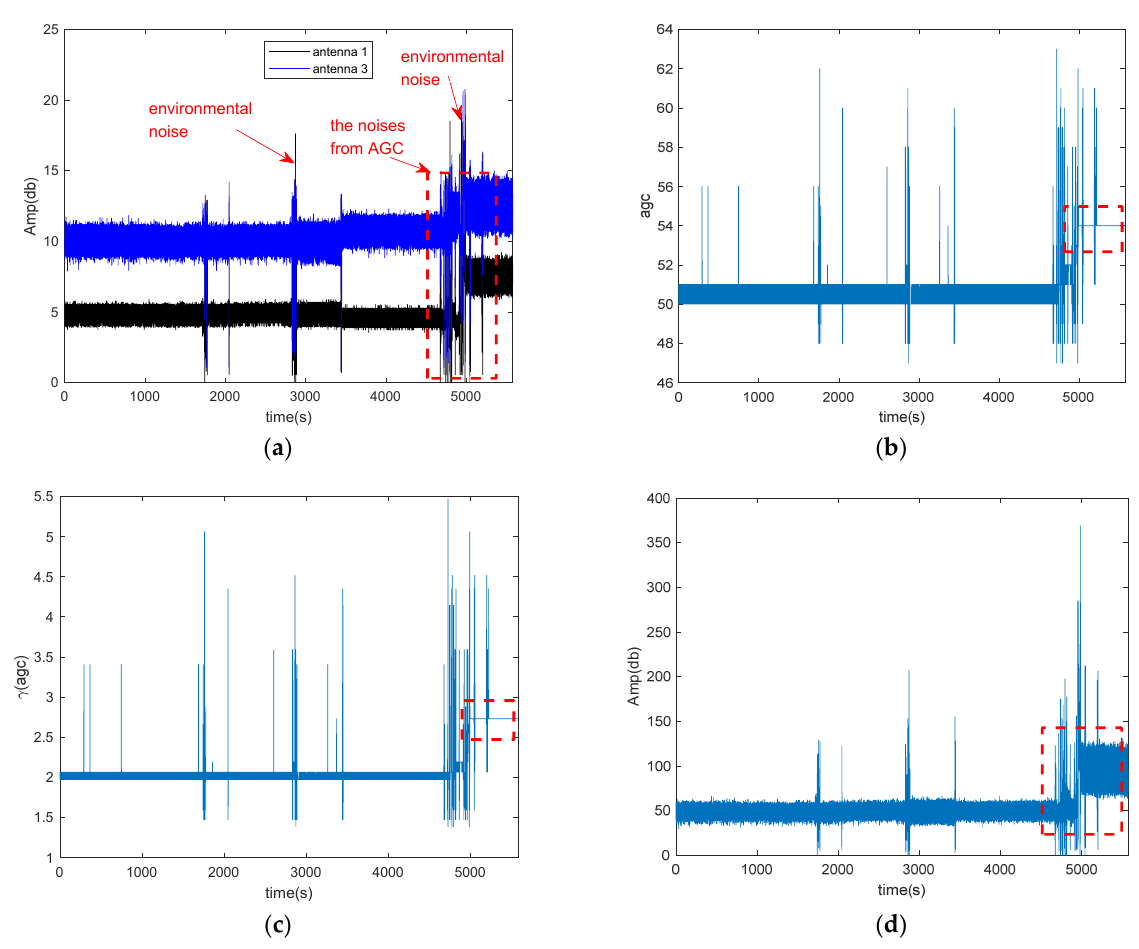
Figure 3. The impact of AGC and environmental noise on the amplitude of CSI in the silence environment. ( a ) CSI amplitude of two antennas; ( b ) the agc of the corresponded CSI amplitude; ( c ) the value of the function of agc; ( d ) the amplitude of conjugate multiplication between the CSI of two antennas.